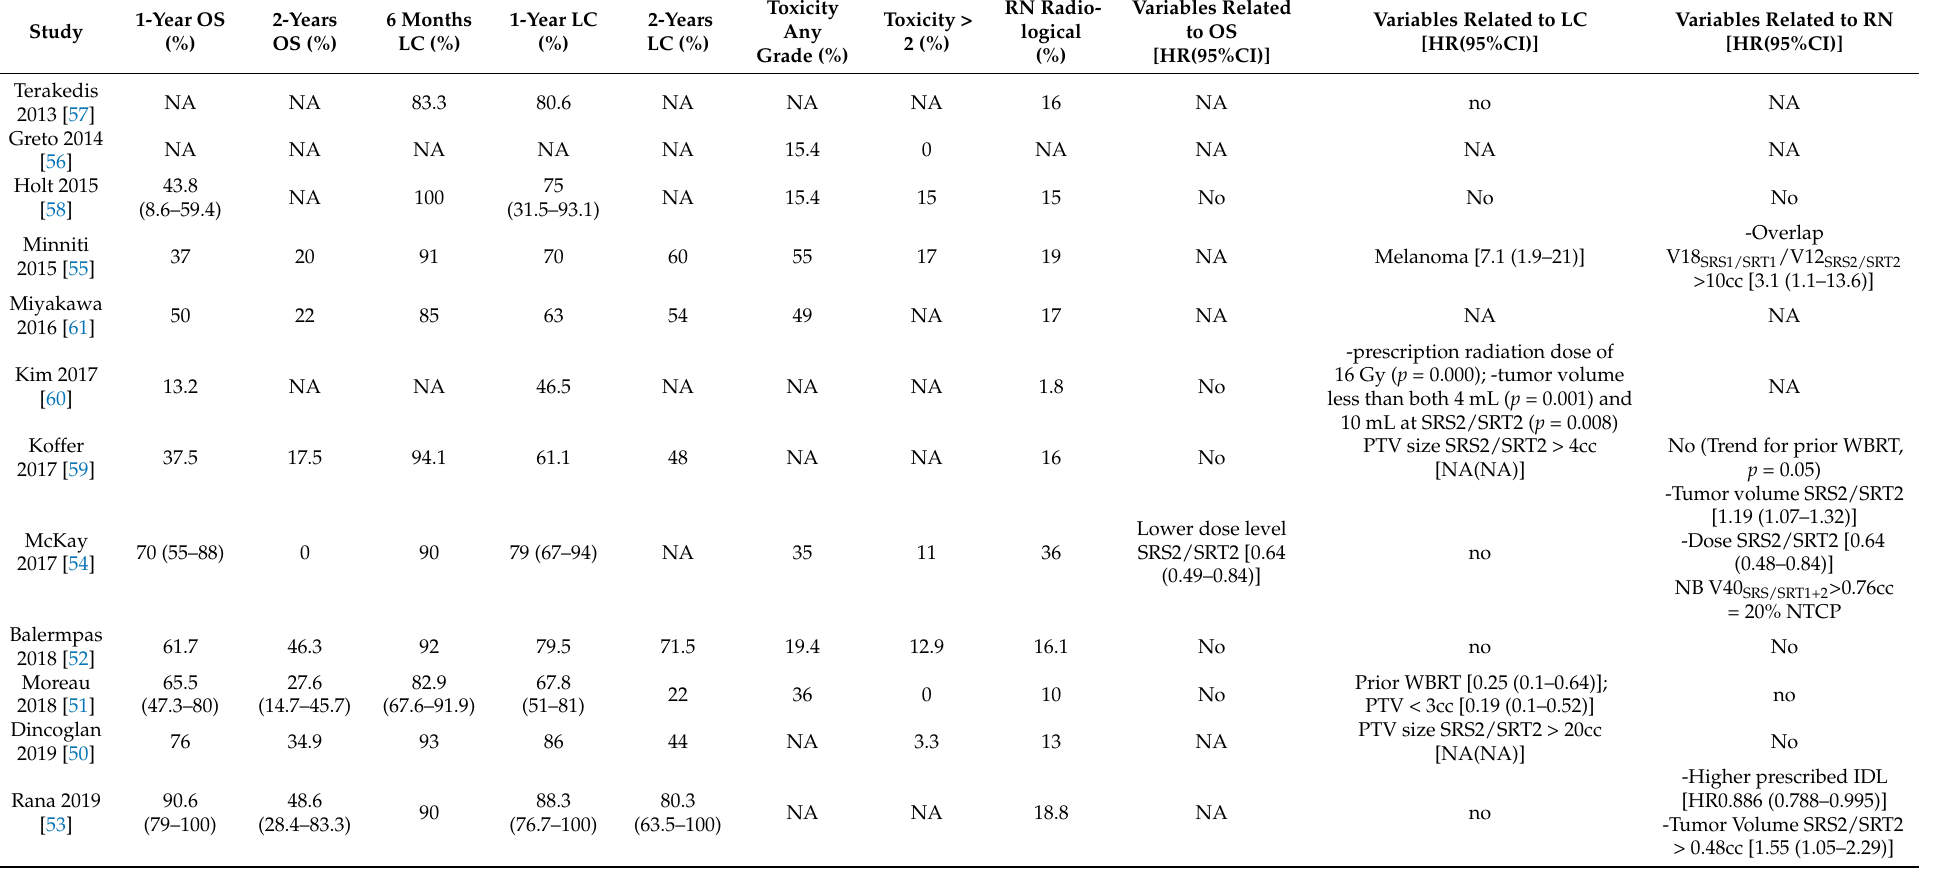
Table 5. Oncological endpoints and